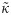
A graph of the time for each simulation to reach the equilibrium steady state, defined as when β(t) reaches its equilibrium value within a tolerance of 1 per cell, plotted against the effective substrate stiffness κ˜.Each point represents an independent simulation with randomly selected initial conditions, varied by four orders of magnitude. The arrow marks the experimental position of the myofibroblast transition and the dashed lines mark the ‘crossover region’ of Fig 6.